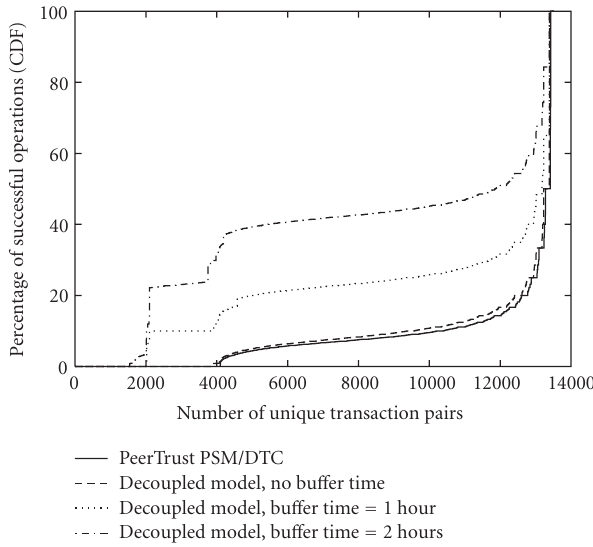
Figure 12: Performance of PeerTrust and our decoupled approach in overcoming network